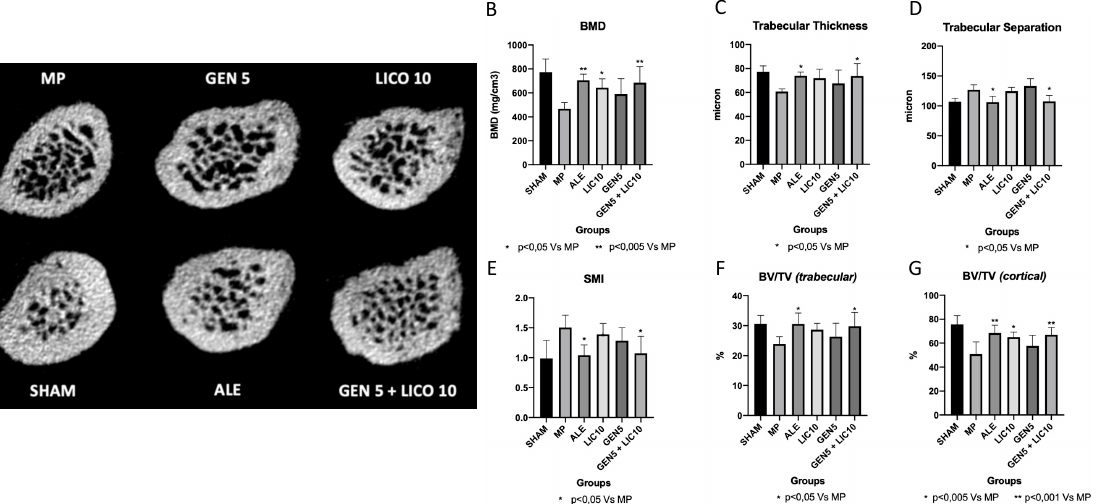
Figure 4. µ CT axial images obtained at the level of the femoral neck ( A ); bone mineral density ( B ); trabecular thickness ( C ); trabecular separation ( D ); structure model index ( E ); trabecular bone volume/total volume ( F ); cortical bone volume/total volume ( G ). Images show reduced cortical bone thickness with areas of endosteal cortical erosion in the MP vehicle, with an increase in trabecular space and a reduction in trabecular thickness. On the contrary, ALE, and GEN LICO groups showed an increased cortical and trabecular thickness, with a reduction of the trabecular spaces.